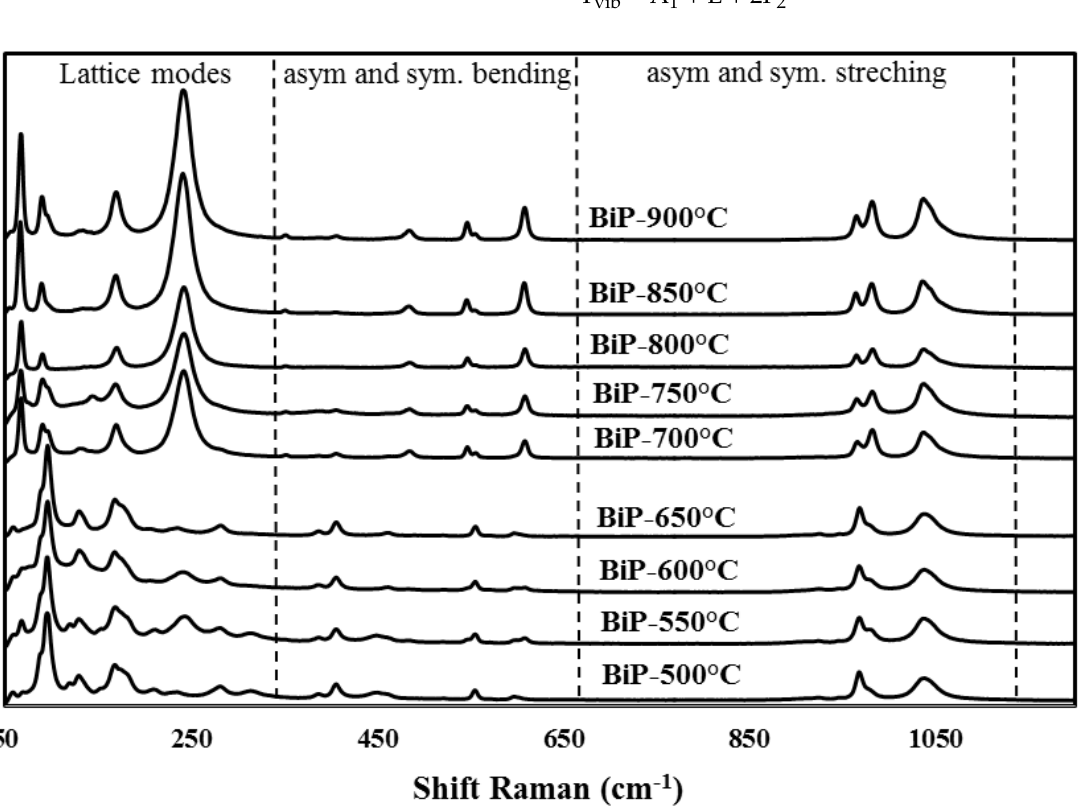
Figure 4. Raman spectra of bismuth phosphate BiPO 4 obtained at different thermal treatments. Table 4. Raman spectroscopy data and assignments of vibration bands for the monoclinic phases of BiPO 4 . Raman Data. Wavenumbers in cm −1 .